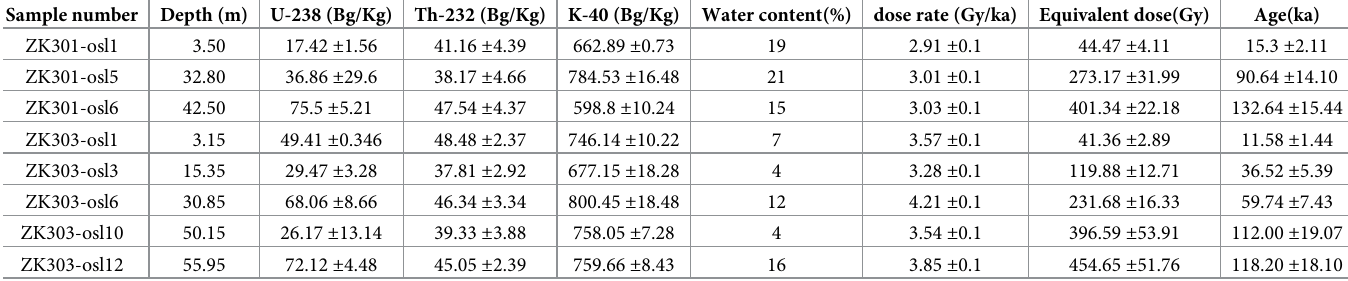
Table 3. The test results of dating